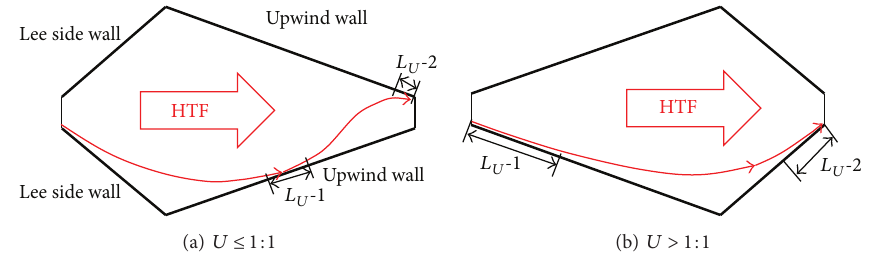
Figure 12: Schematic plot of flow field near the wall.